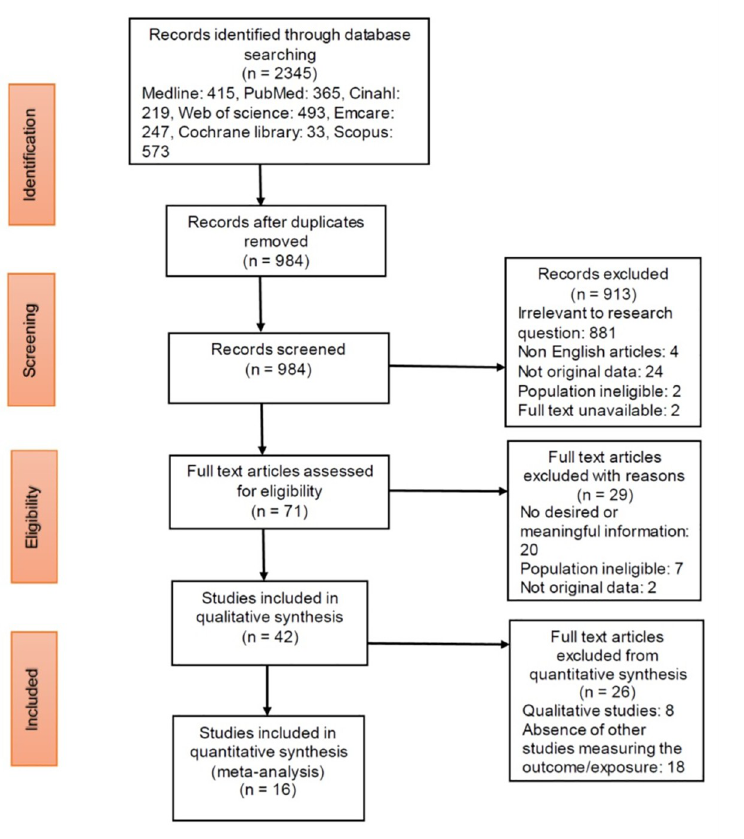
Fig 1. Study flow diagram. Study selection process and reasons for